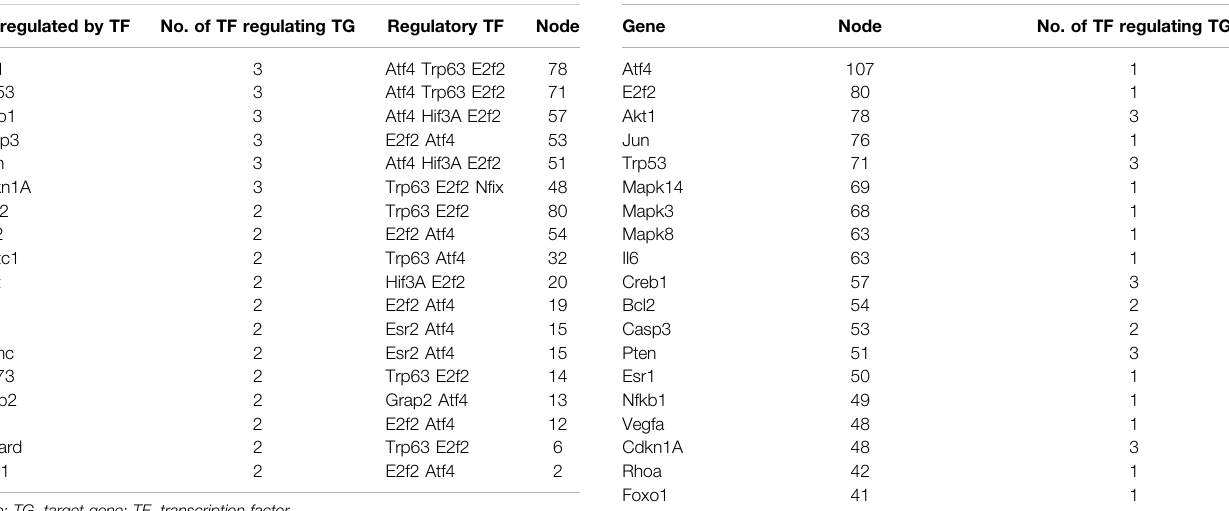
TABLE 3 | Statistics of network nodes.